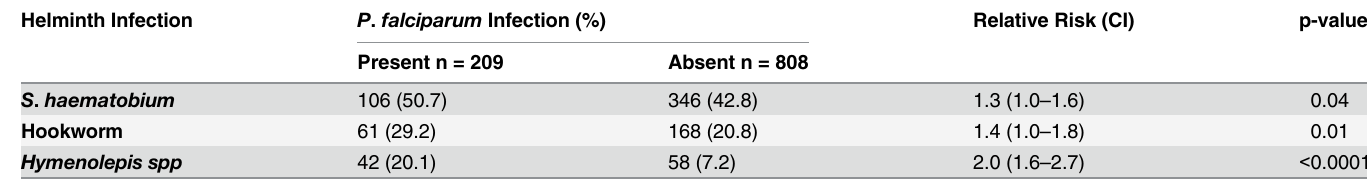
Table 5. Associations between helminths and Plasmodium falciparum infection, according to helminth species. Helminth Infection P . falciparum Infection (%)